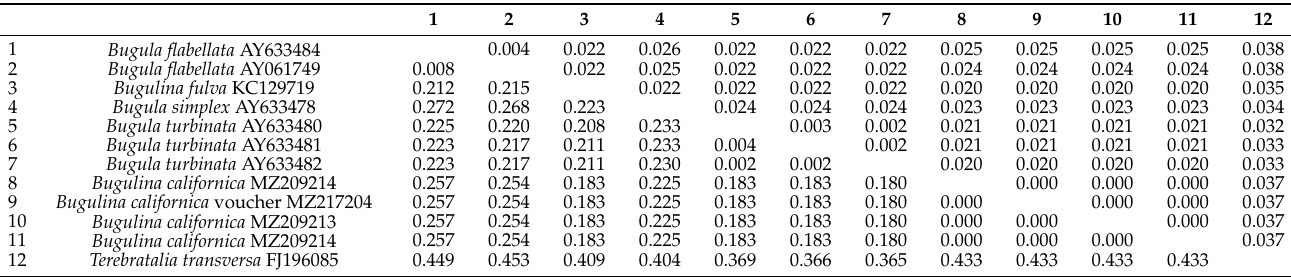
Table A2. Pairwise distances between nucleotide sequences of mitochondrial cytochrome c oxidase I according to phyloge- netic calculations performed using MEGA 7.0. The distances and standard errors are shown in the lower-left matrix and upper-right matrix,